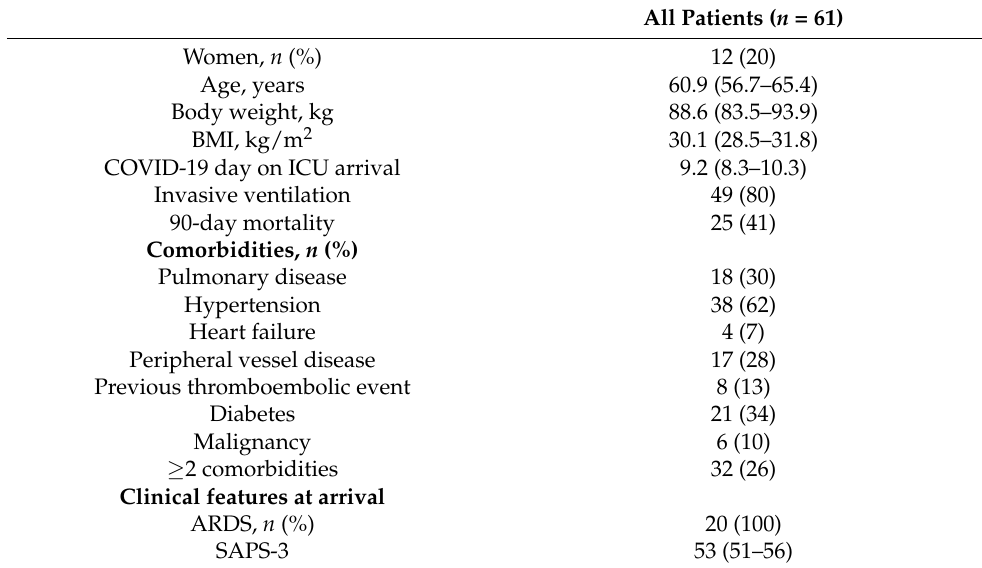
Table 2. Patient demographic characteristic and